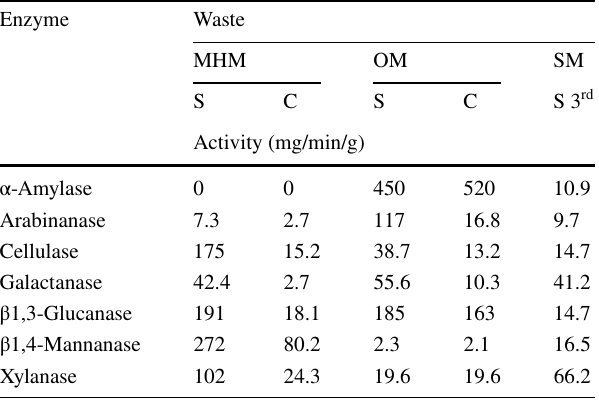
Table 1 Polysaccharide hydrolase activities